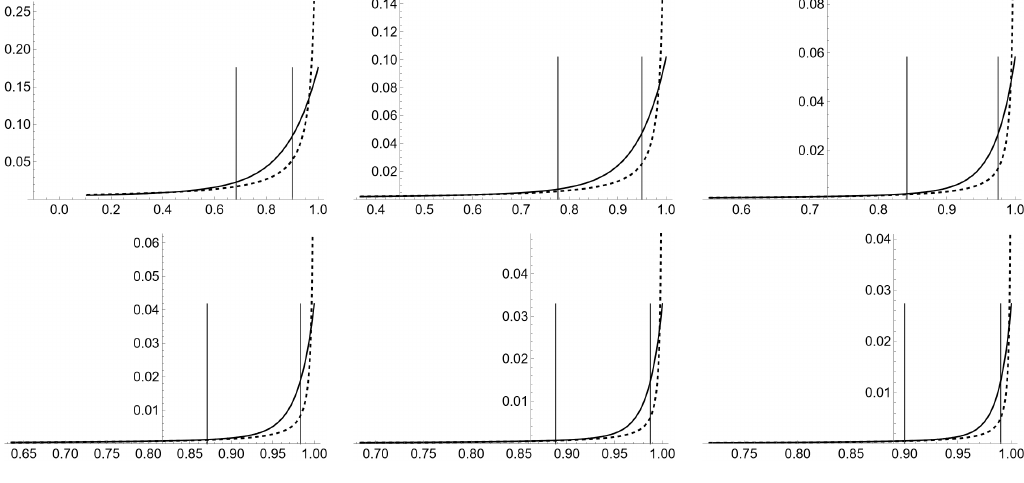
√ √ 2 / N and u = 1 − 2 /N .